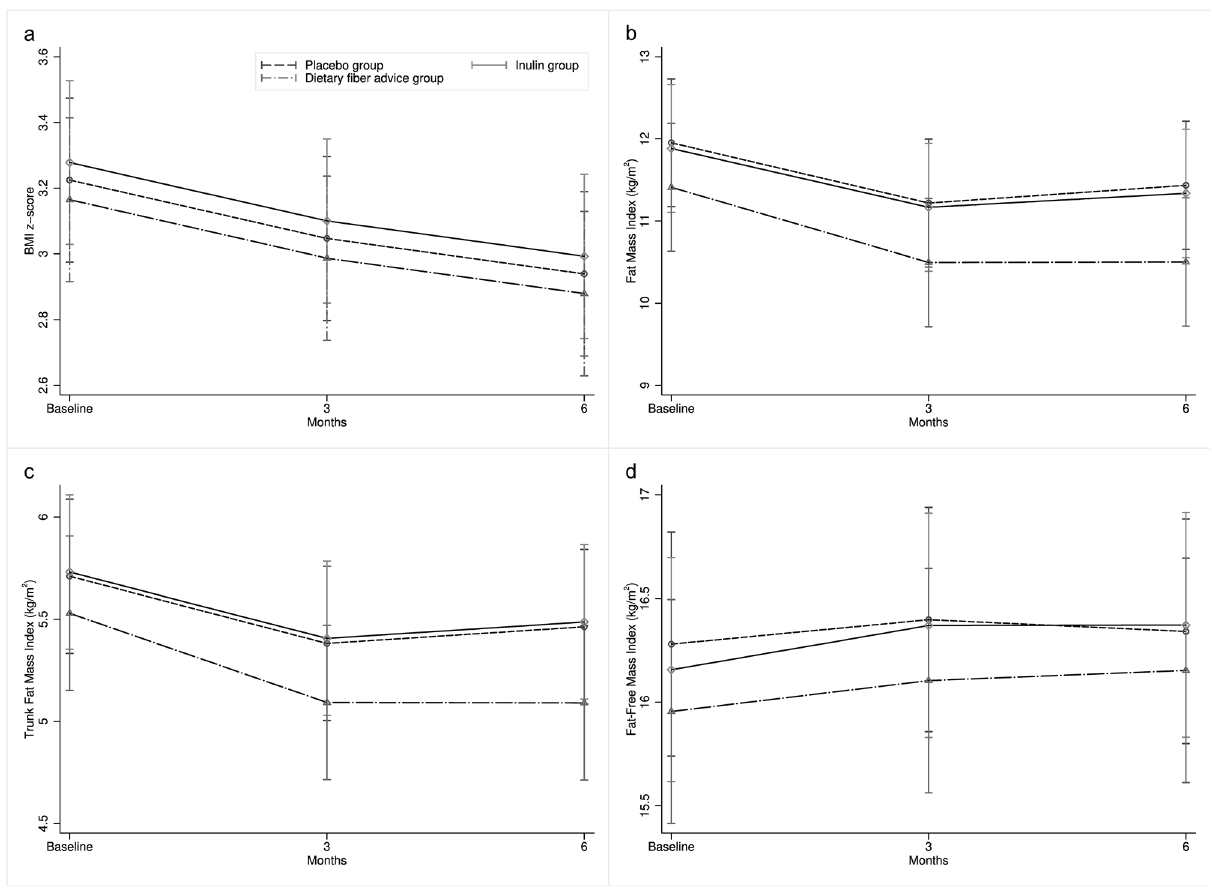
Figure 2. Changes in ( a ) BMI z-score, ( b ) fat mass index, ( c ) trunk fat mass index, and ( d ) fat-free mass index over the 6-month intervention from Generalized Estimating Equation (GEE) model (adjusted mean of outcomes). BMI-z score decreased in all groups (P < 0.0001). Fat mass index (FMI) and trunk FMI rapidly declined in the first 3 months and then remained stable until the 6th month. Fat-free mass index (FFMI) significantly increased in the inulin group through the study (P = 0.009, 95% CI 0.053–0.379), whereas the control and dietary fiber advice groups did not. The GEE slope of FFMI in inulin group increased dramatically, especially in the first 3 months and grew slightly until the 6th month. Between-group comparison shows no significant differences of the changes in BMI z-score, FMI, trunk FMI, and FFMI in 3 time-points (month 0, 3,